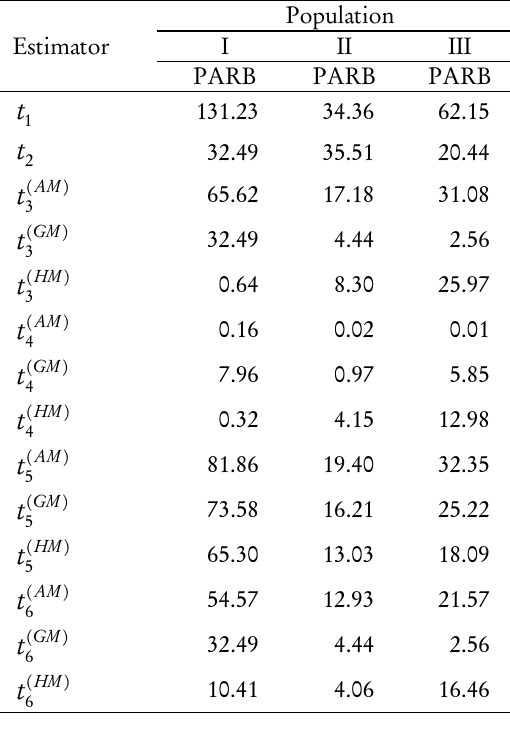
The PARBs of different estimators.